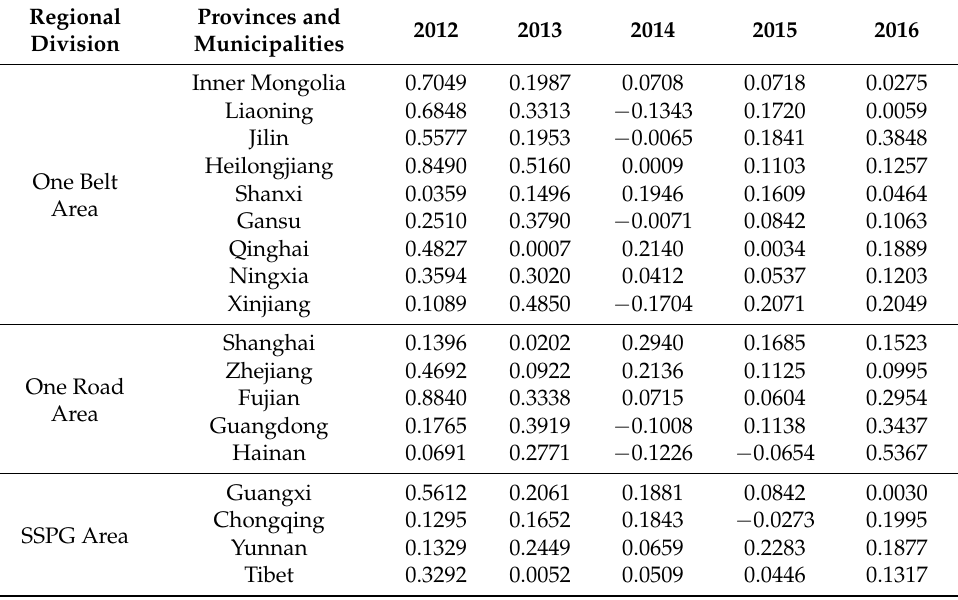
Table A2. The marginal growth rate of the One Belt and One Road region in China from 2012 to 2016.